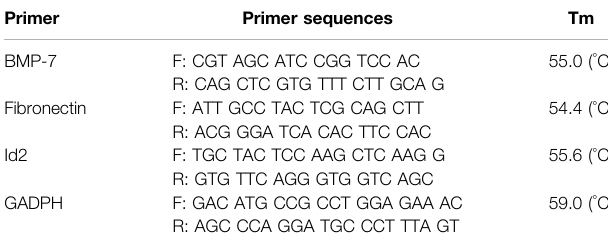
TABLE 2 | Primer sequences of RT-qPCR.